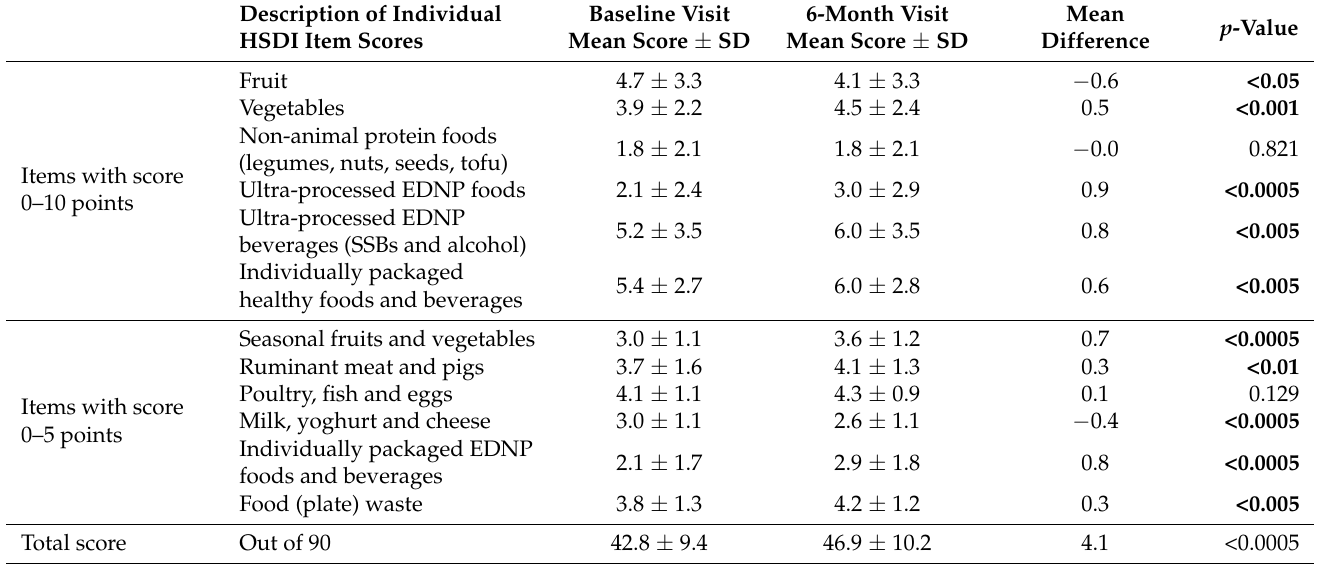
Table 6. Paired-sample t -test to assess the test–re-test reliability of the HSDI between data collected baseline and six months. Presented as HSDI scores * on participants who completed the study ( n =